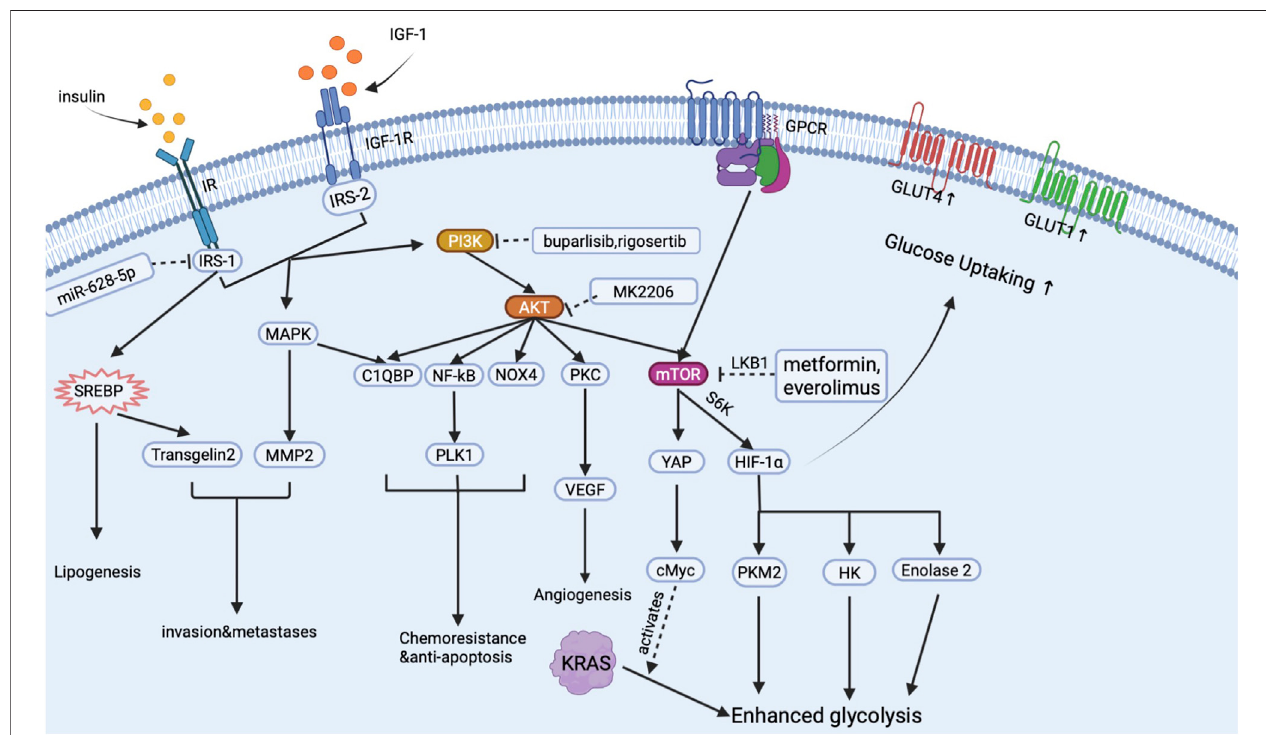
FIGURE 2 | Signal pathways activated by insulin in pancreatic cancer